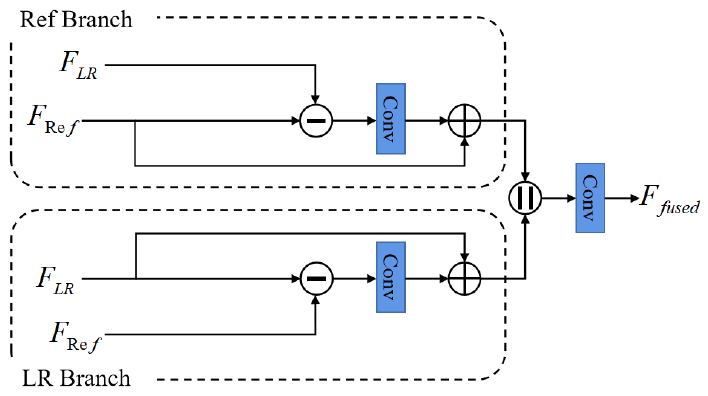
Figure 4. An illustration of the proposed dual projection fusion module